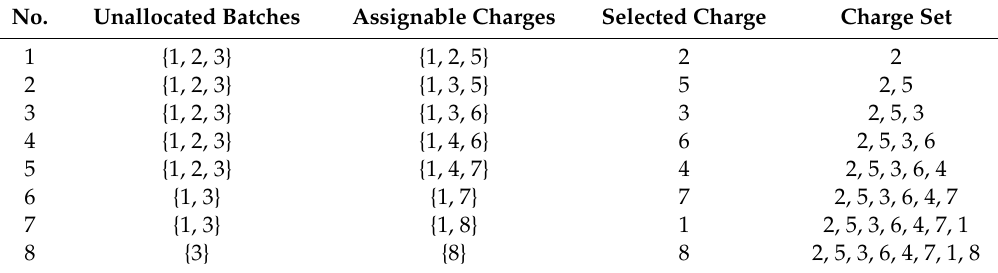
Table 3. Process of heuristic initialization under batch sequence [2, 3,